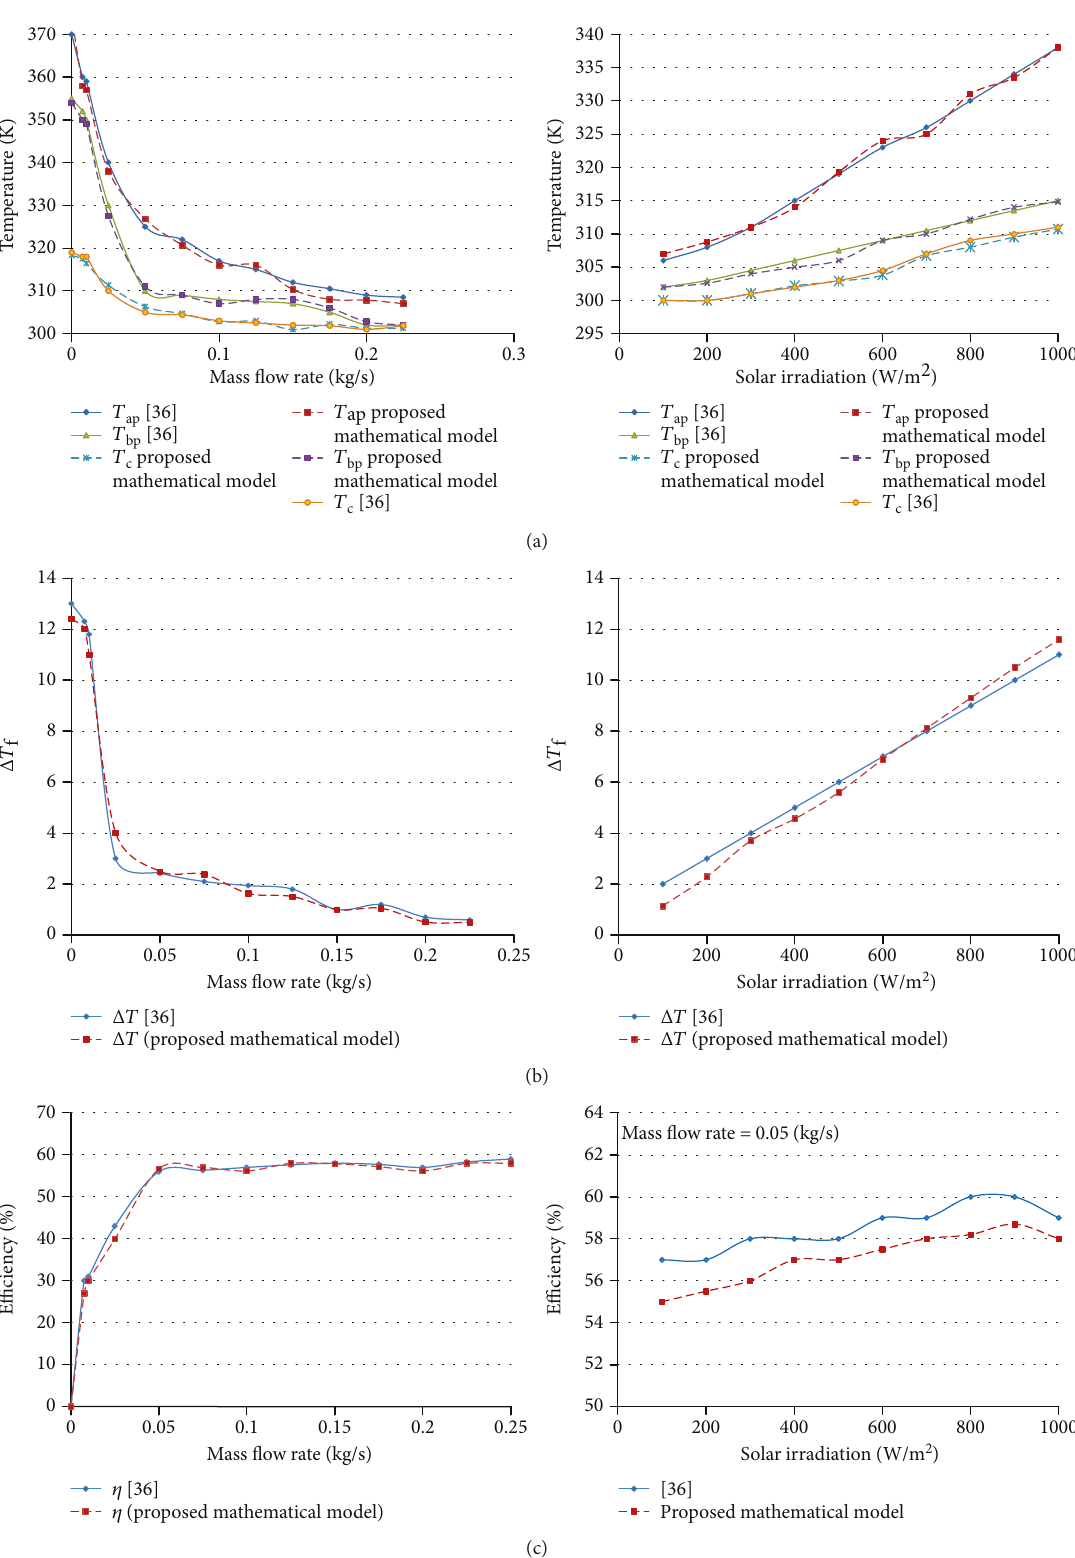
Figure 14: Comparison of solar air heater performance parameters obtained from the proposed mathematical model and that in [36]. (a) Predicted temperature of absorber plate, bottom plate, and glass cover plate of SAH versus mass fl ow rate and solar irradiation. (b) Predicted fl uid temperature di ff erence versus mass fl ow rate and solar irradiation. (c) Predicted SAH e ffi ciency versus mass fl ow rate and solar